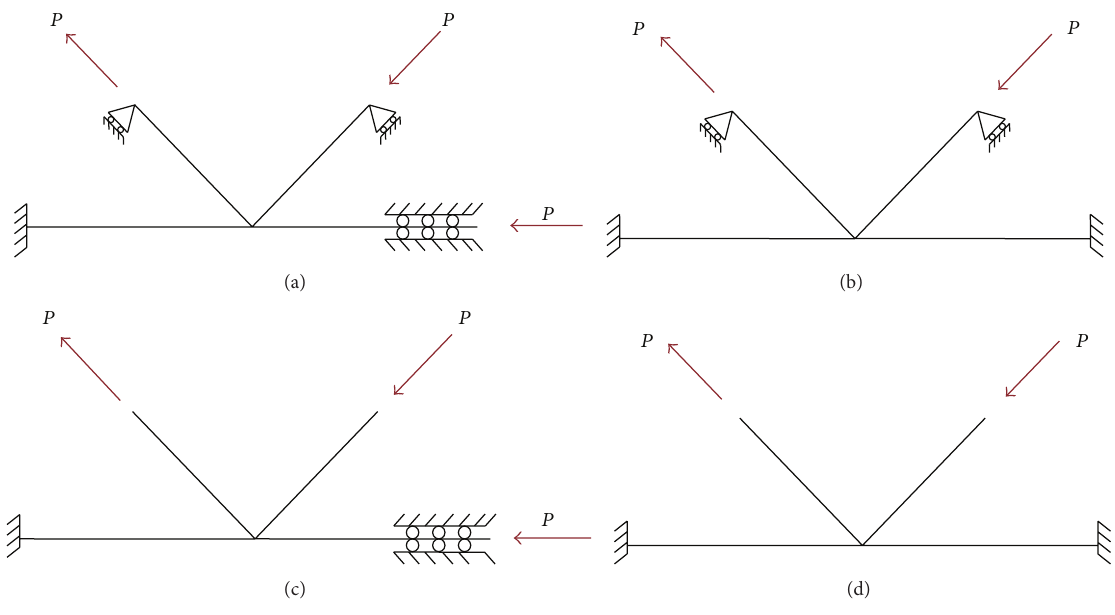
Figure 7: Boundary conditions and loading mode.